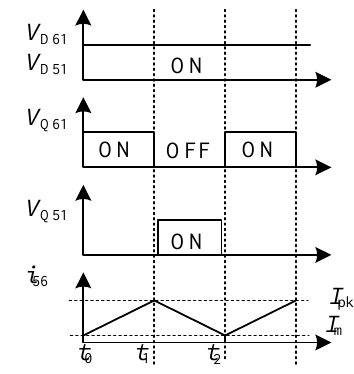
Figure 6. The current paths of Case 1.